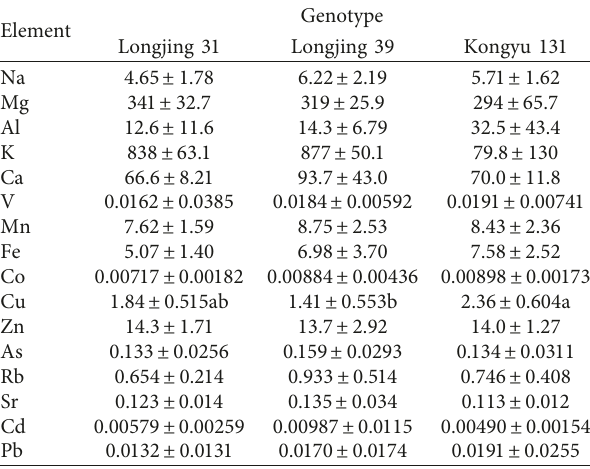
Different letters in rows are statistically significantly different at P < 0 . 05. Table 5: Elements for all rice samples among three different ge- notypes at Jiamusi from the year of 2014 ( µ g · g − 1 ).